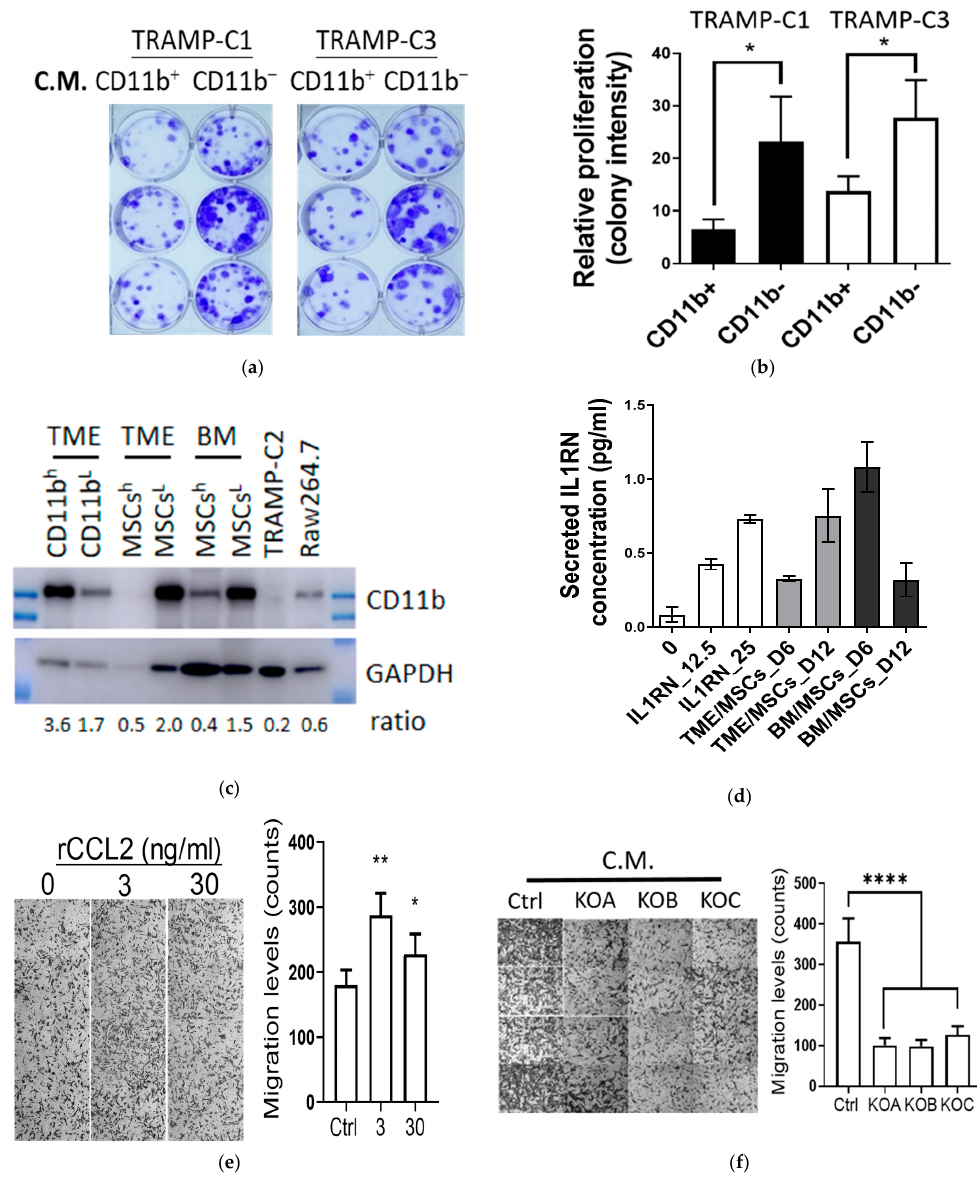
Figure 2. Tumor cell-derived CCL2 is involved in regulation of the migration activities of MSCs ( a ) Colony-formation assays using conditioned media (C.M.) collected from the CD11b ⁺ and CD11b − leukocytes in the TRAMP-C1-derived tumors. C.M. was applied to two mouse prostate cancer cells (TRAMP-C1 and TRAMP-C3). ( b ) Colony numbers were quantified and compared (right). n = 3. ( c ) Comparison of the CD11b expression of different cell populations by Western blotting assay. Single cell suspension collected from the TME or bone marrow (BM) was treated with either a CD11b or MSCs enrichment kit. CD11b h and MSC h : enriched populations. CD11b L and MSC L : non-enriched populations. Ratio: images were quantified and presented as CD11b/GAPDH. ( d ) Detection of